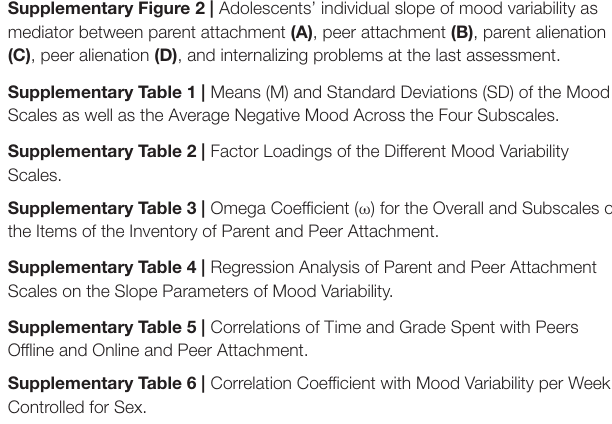
Supplementary Table 4 | Regression Analysis of Parent and Peer Attachment Scales on the Slope Parameters of Mood Variability. Supplementary Table 5 | Correlations of Time and Grade Spent with Peers Offline and Online and Peer Attachment. Supplementary Table 6 | Correlation Coefficient with Mood Variability per Week Controlled for